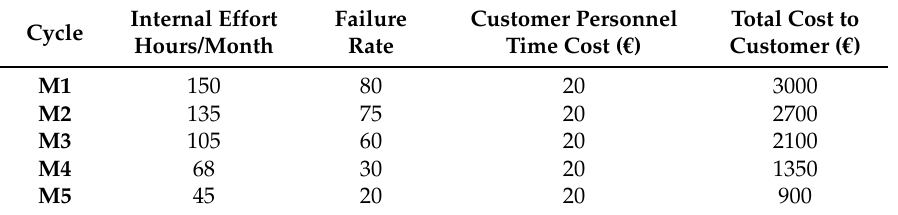
Table 3. Description of the costs in resources for the monthly maintenance of the company’s ISMS. Internal Effort Failure Customer Personnel Cycle Hours/Month Rate Time Cost ( € )